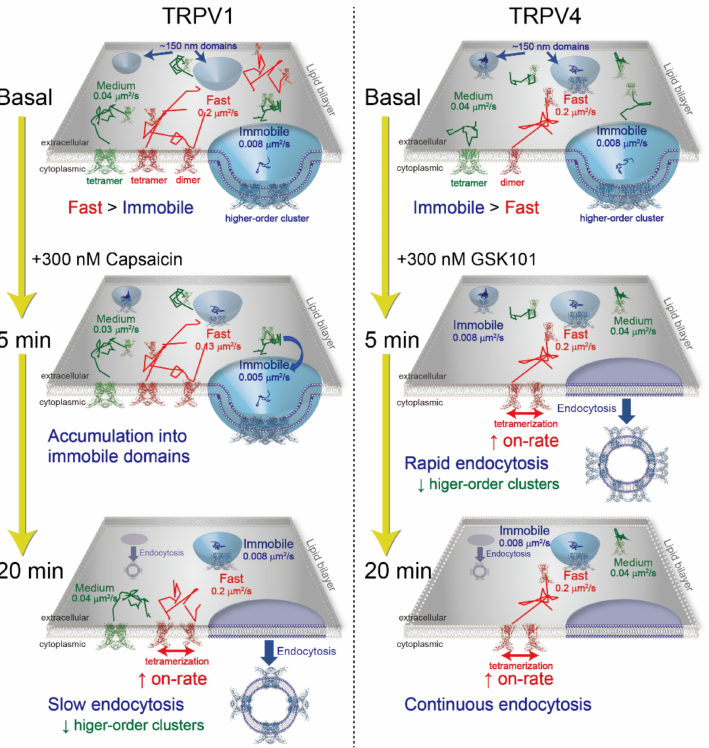
Figure 6. Schematic representation of TRPV1 and TRPV4 channel diffusion in the plasma membrane after activation. The equilibrium among the three diffusion states (immobile, medium, and fast) and the particle densities of TRPV1 and TRPV4 changed temporarily upon agonist